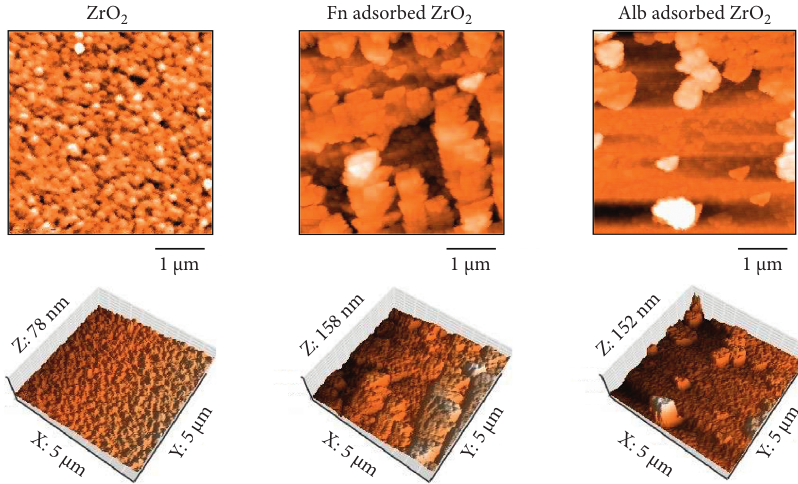
Figure 4: AFM images of a native ZrO 2 sensor and Fn- and Alb-adsorbed ZrO 2 sensor. Table 1: Surface roughness (Sa) and contact angle of a native ZrO 2 sensor and Fn- and Alb-adsorbed ZrO 2 sensor surfaces ( n Sensor ZrO 2 Fn adsorbed ZrO 2 Alb adsorbed ZrO 2 6.63 (4.50) a,b 24.38 (2.31) e Values in brackets are SD. Different superscript letters indicate a significant difference ( P < 0 . 05).